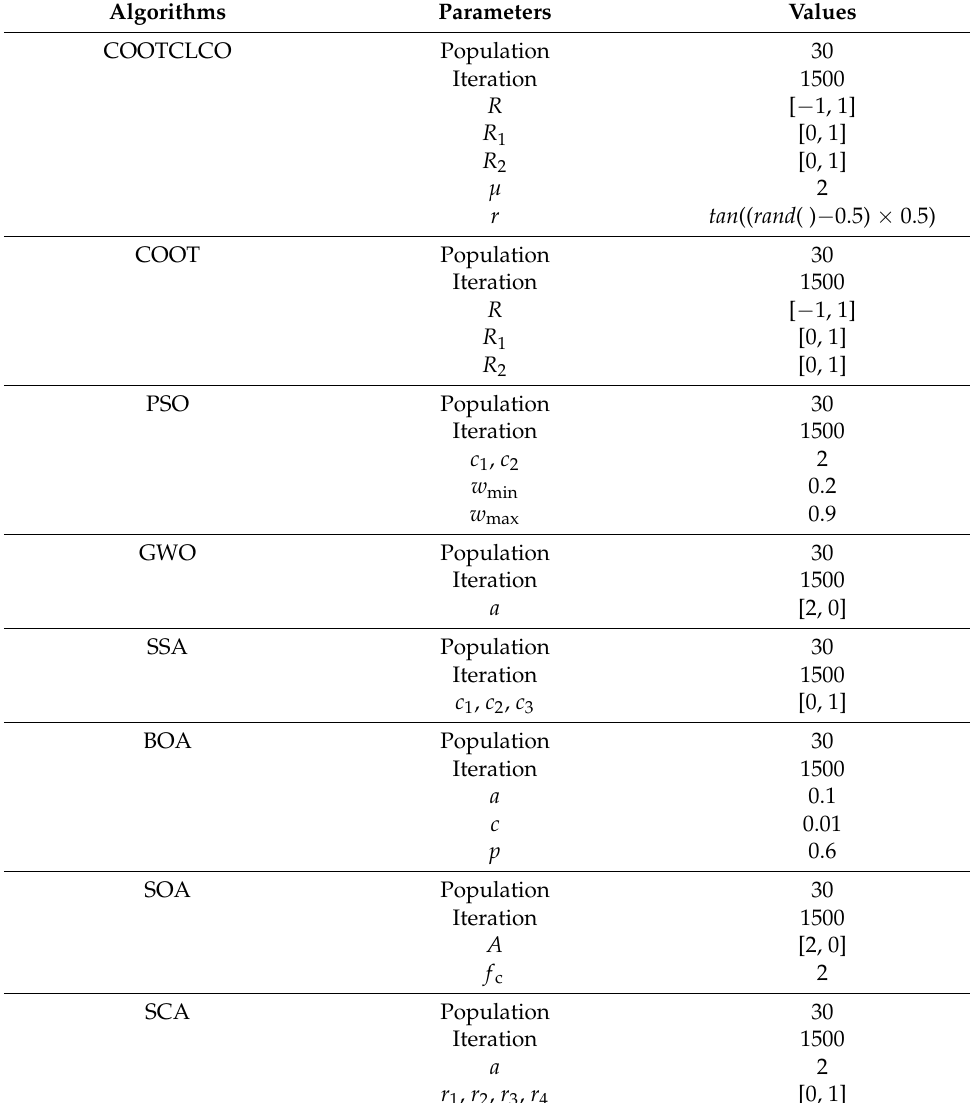
Table 5. Parameter settings of the